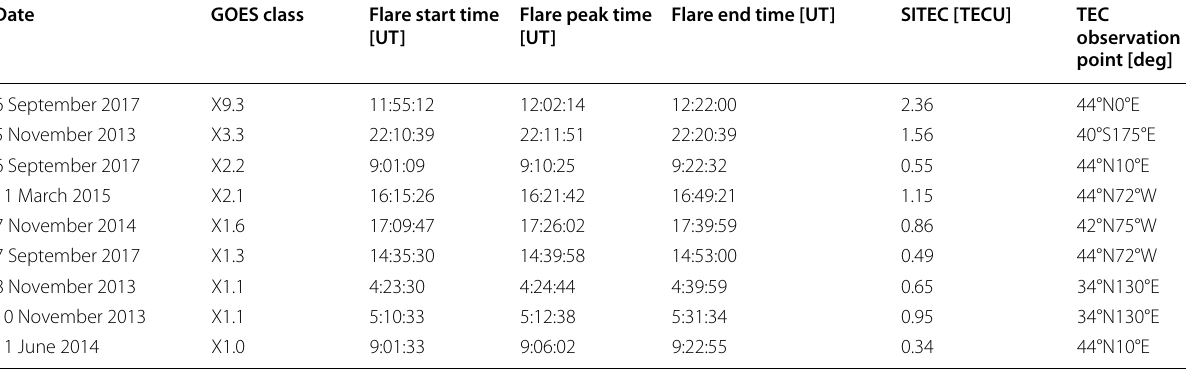
Table 1 Flare parameters and TEC parameters for the nine flare events analyzed in this